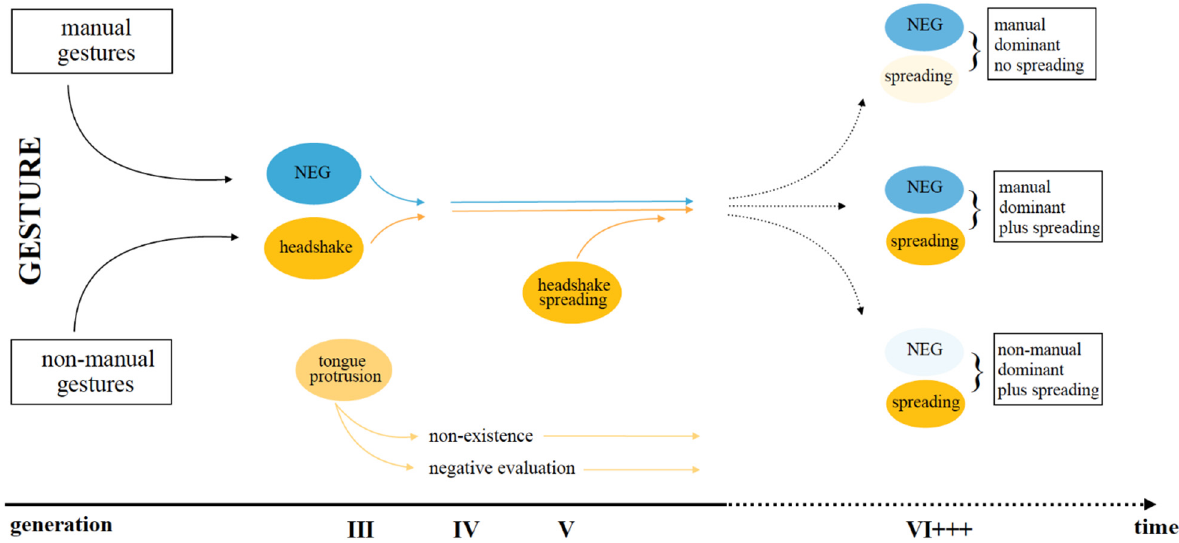
Figure 4. Sketch of possible grammaticalization scenarios of the main two negation markers in Kata Kolok. Note that the pathway for tongue protrusion is not integrated into the main pathway of negation given the low numbers attested in this study. Instead, tongue protrusion is kept as a somewhat separate pathway with more specialized, i.e., restricted, negative meanings.